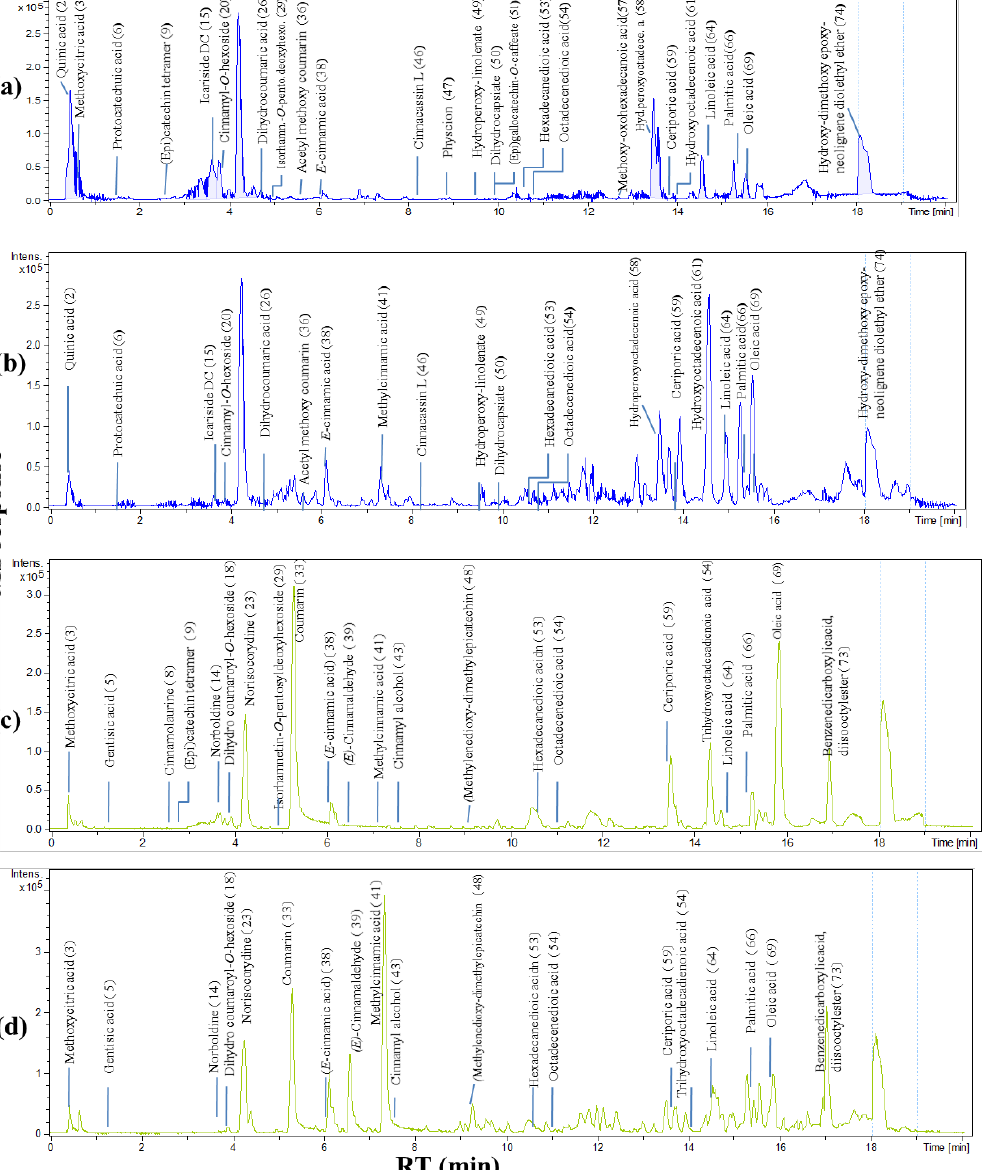
Figure 1. Representative Ultra -Performance Liquid Chromatography–Mass Spectrometry